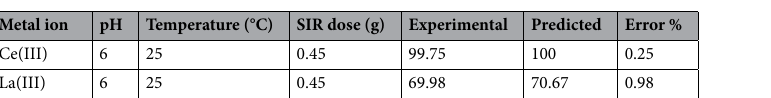
Table 6. The optimum condition derived from RSM for Ce(III) and La(III) ions adsorption.